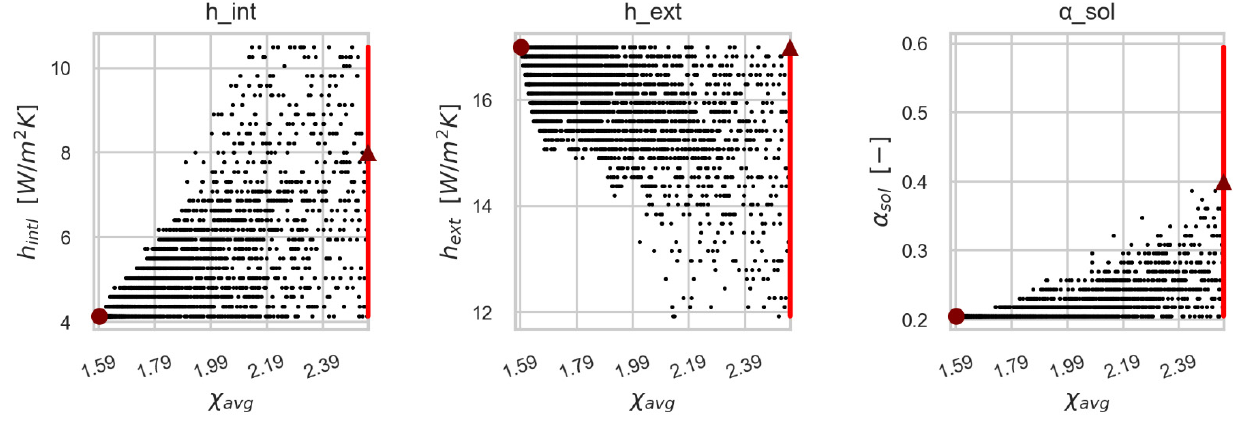
Figure 12. Overview of the second optimization results conducted on internal, external heat coefficient and the surface absorption coefficient.